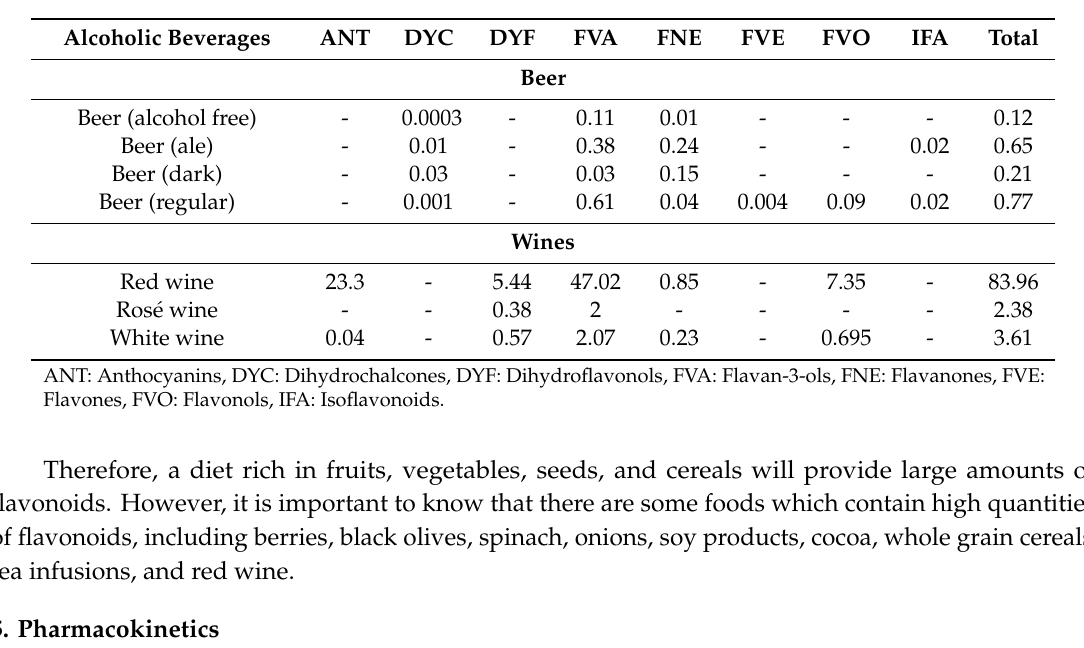
Table 8. Flavonoid contents of alcoholic beverages (mg / 100 g drink and mg / 100 mL wine)